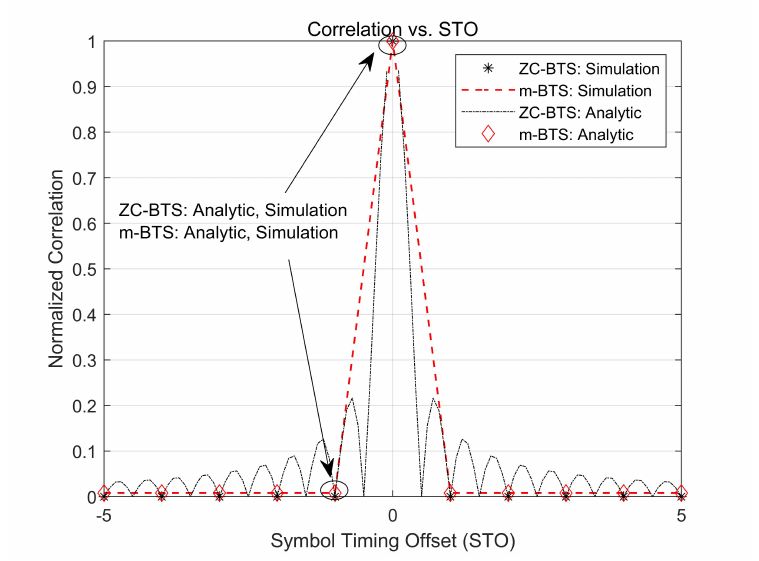
Figure 4. Correlation property of the ZC-BTS and m-BTS in the presence of the STO.